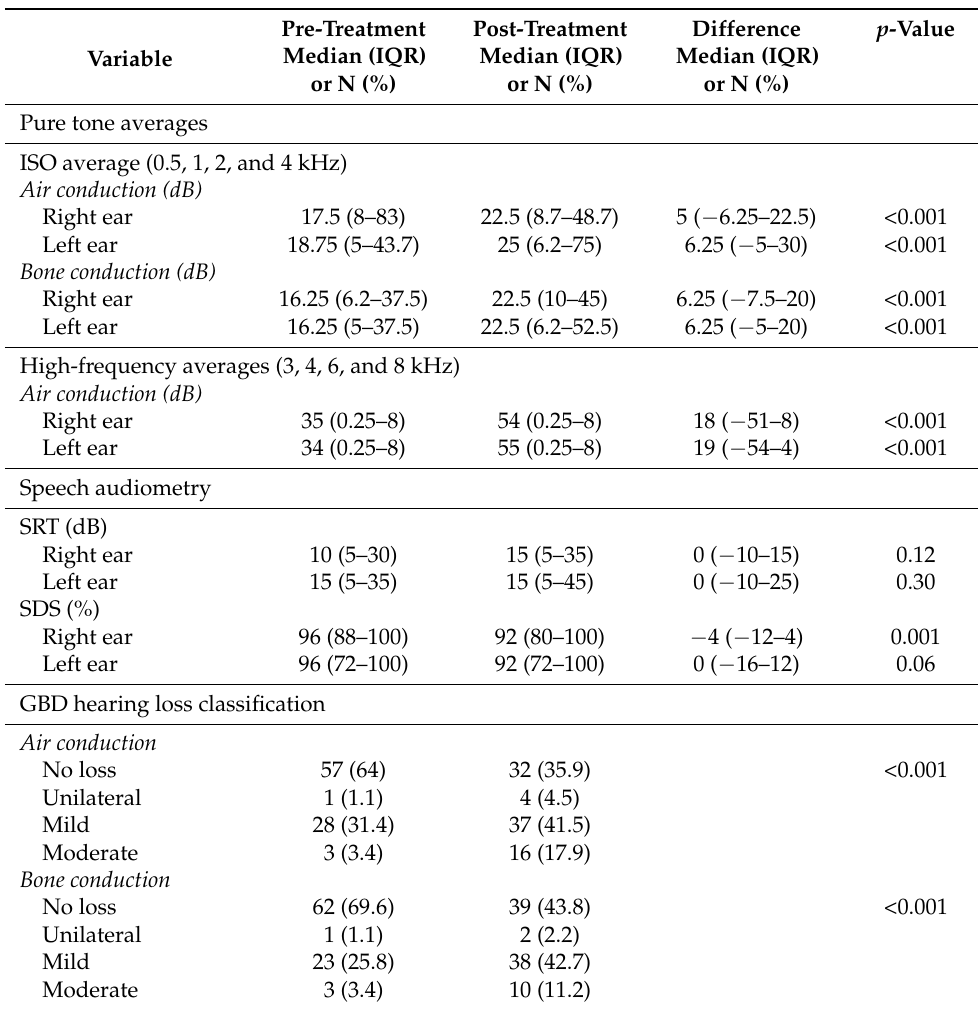
Table 3. Pure tone audiometry, speech audiometry, and hearing classifications before and after cisplatin chemoradiation